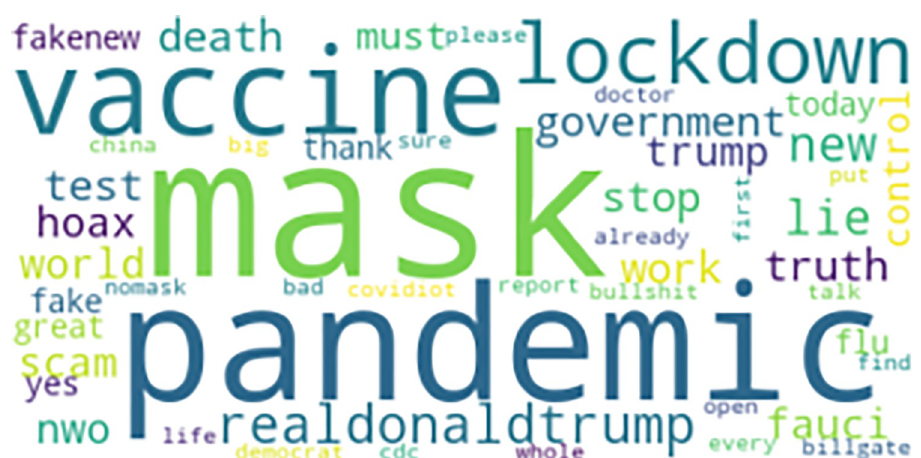
Fig 1. Word cloud of common words used in